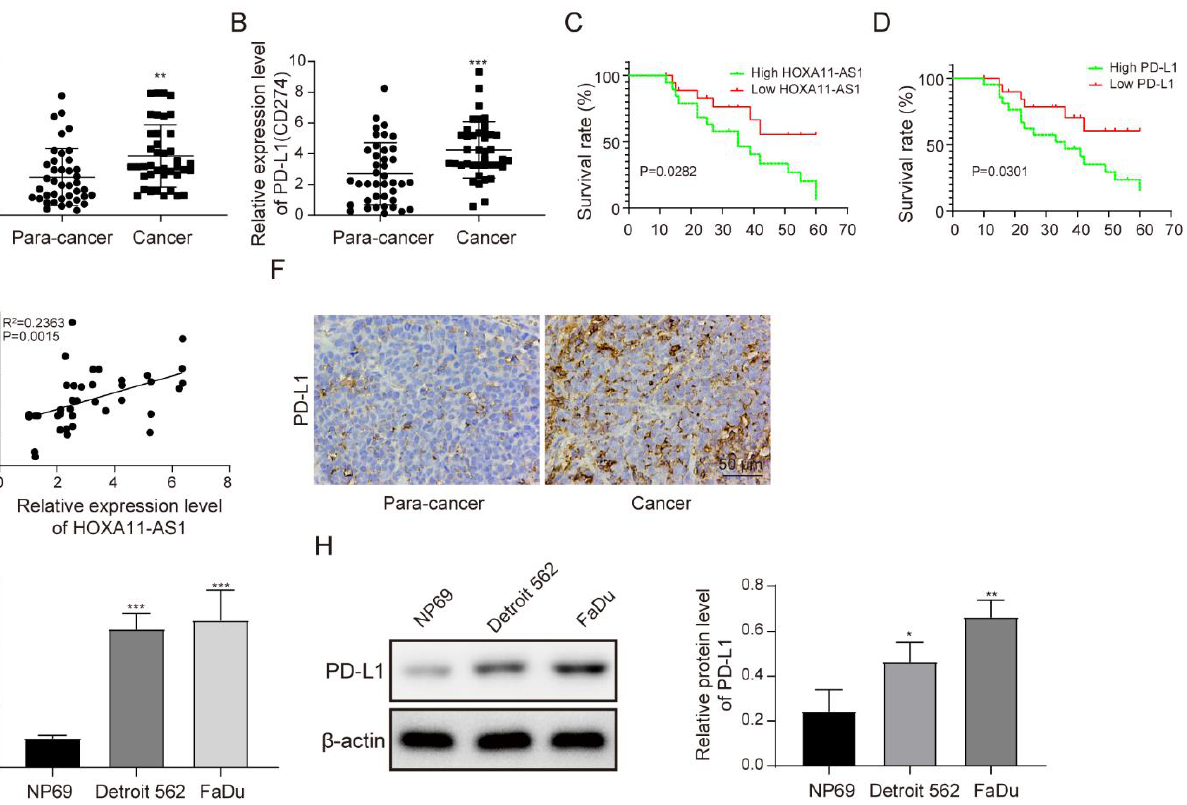
Figure 1. HOXA11-AS1 and PD-L1 were upregulated in HSCC, and HOXA11-AS1 positively correlated with PD-L1. ( A , B ) HOXA11-AS1 and PD-L1 expression in 40 HSCC tissues and matched peri-carcinomatous tissues measured by RT-qPCR. ( C , D ) Kaplan–Meier overall survival curve stratified by HOXA11-AS1 and PD-L1 expression. GraphPad was utilized to calculate the Kaplan–Meier plots, and 40 HSCC patients were included. The high/low expression of HOXA11-AS1 was defined by the median of its expression level, with higher than the median as high expression and lower than the median as low expression. Survival analysis was used. ( E ) The correlation between HOXA11-AS1 and PD-L1 expression was analyzed by Pearson’s correlation coefficient, n = 40. ( F ) PD-L1 expression in HSCC tissues was measured by immunohistochemical staining. ( G , H ) HOXA11-AS1 mRNA expression and PD-L1 protein levels in NP69 and HSCC cells (FaDu and Detroit 562 cells) detected by RT-qPCR and Western blot, respectively; n = 4. * p < 0.05, ** p < 0.01, *** p < 0.001. Original Blots see Supplementary File Figure S1.